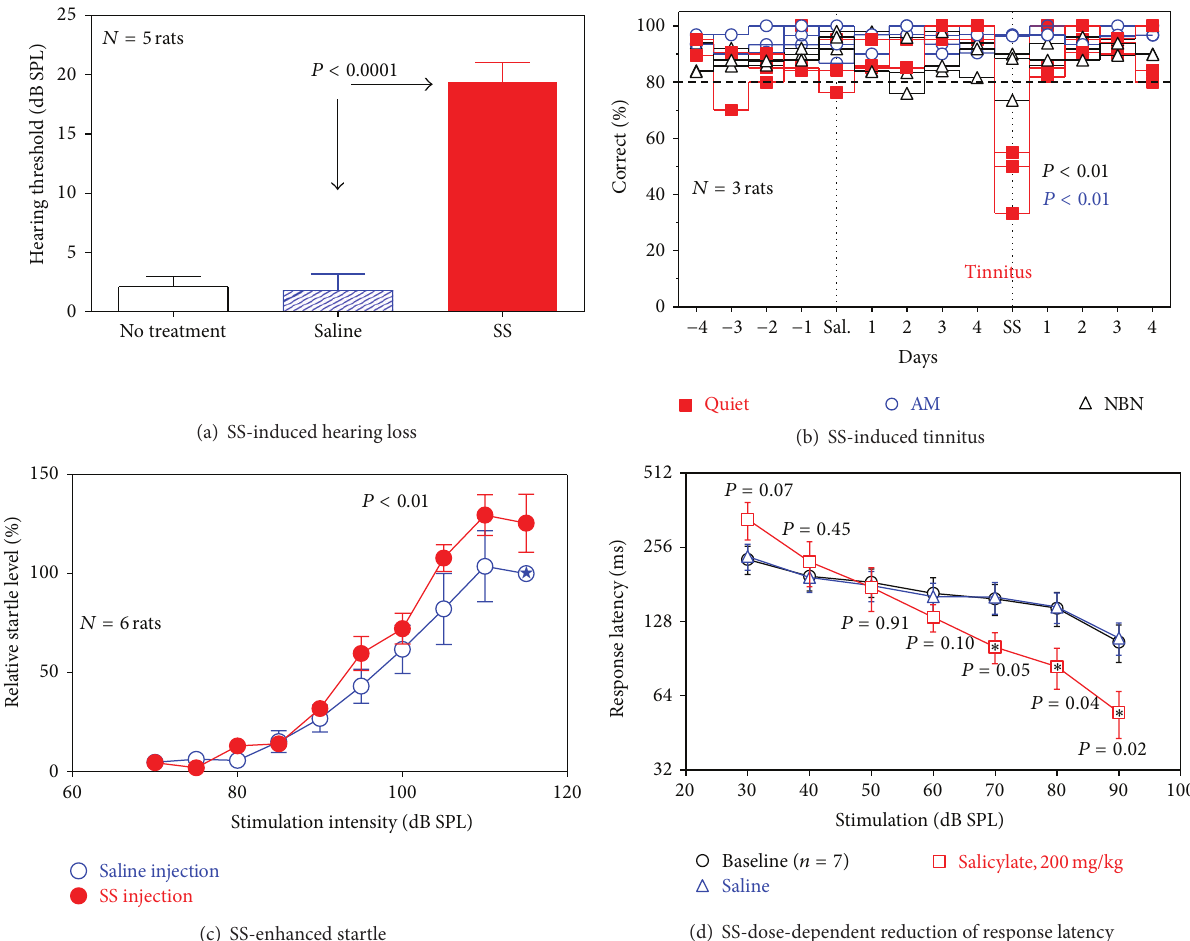
Figure 2: The effects of sodium salicylate (SS) injection on auditory perception. (a) Mean hearing thresholds for broadband noise bursts ( 𝑛 = 5 ). Baseline (black open bar), saline (blue shadowed bar), and salicylate (red filled bar) conditions are shown with standard error (SE) bars. Thresholds significantly increased by about 17dB following salicylate administration; (b) salicylate-induced tinnitus. Rats ( 𝑛 = 3 ) were trained to respond to 3 stimuli. Quiet (red filled squares) and amplitude modulated (AM) (blue open circles) stimuli were paired with the right feeder while a narrowband noise (NBN) (black open triangles) was paired with the left feeder. Injection of saline (sal) showed no significant difference in responding during Quiet trials compared with baseline (no injection). However, an injection of 200 mg/kg SS showed a significant difference in response only during Quiet trials. This switch in response suggests that the rats perceived a steady state sound in the absence of an acoustic source. (c) Mean percentage ( ± SE) of startle amplitude relative to saline control startle amplitudes at 115dB (marked with the star); note significantly increased startle amplitudes after salicylate injection, (d) Mean reaction time measures for broadband noise bursts ( 𝑛 = 7 ). Baseline (black circles), saline (blue triangles), and salicylate (red squares) are shown with standard error (SE) bars. Reaction times for 70, 80, and 90dB SPL noise bursts decreased significantly with salicylate, suggesting an increased sensitivity to loud